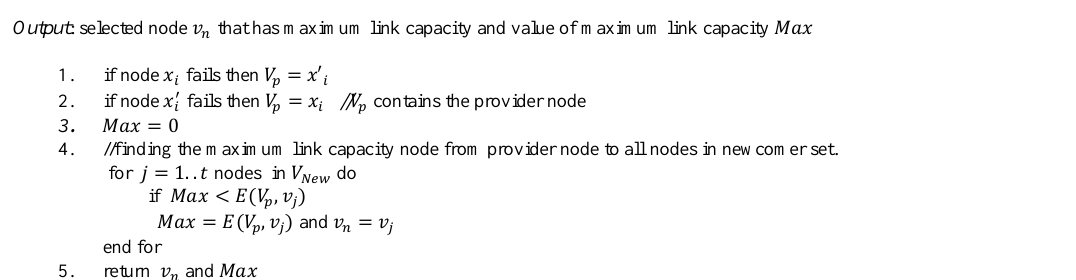
Algorithm 1 for optimized selection of node for data node failure from a given set of newcomers is given